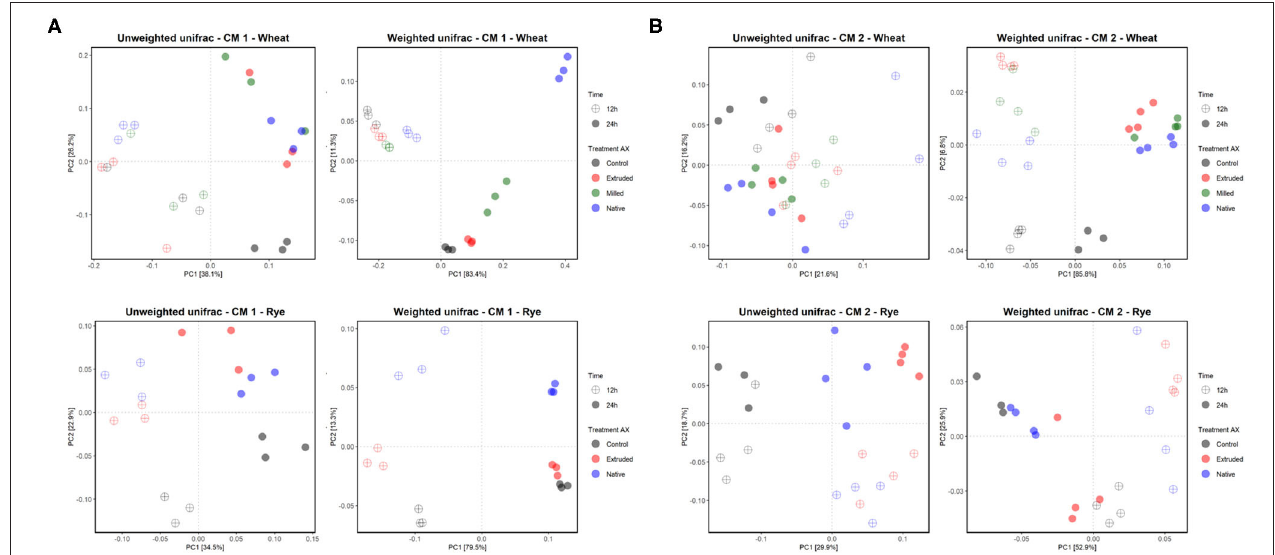
FIGURE 5 | Effect of differently processed AX namely native, extruded, and milled WBAX native and extruded RFAX on the microbiota composition of CM 1 (A) and CM 2 (B) , respectively. PCoA of incubated microbiota based on unweighted and weighted UniFrac analysis matrix on ASV level. Each point represents an in vitro colon microbiota sample after 12 ( ◦ ) or 24h (•) of fermentation and samples are colored based on treatment with control non-AX supplemented